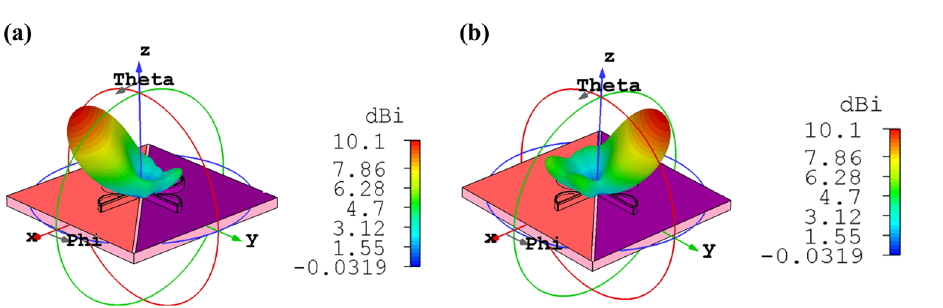
Figure 11. 3D radiation patterns of bidirectional cross dipole nano-antenna which acts as the unidirectional one dynamically, when ( a ) µ 1 = 0 eV , µ 2 = 0 .51eV and ( b ) µ 1 = 0 .51eV , µ 2 = 0 eV